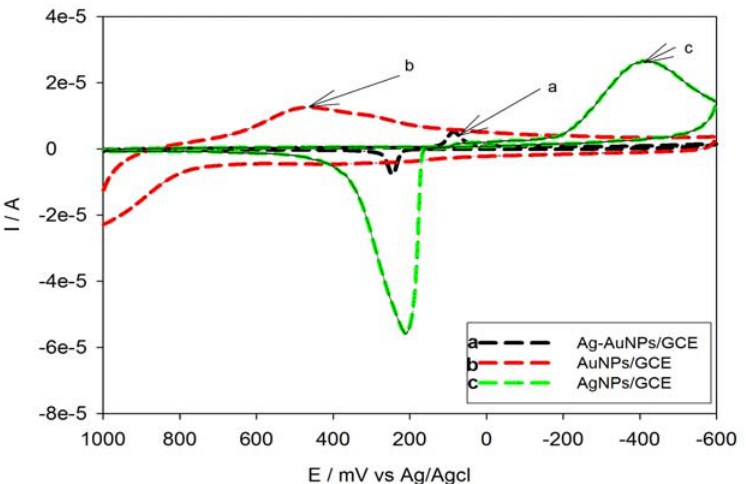
Figure 4 . Cyclic voltammograms of the overlay of Ag-AuNPs/GCE (curve a ), AuNPs/GCE (curve b ) and AgNPs/GCE (curve c ) in 0.1 M phosphate buffer pH 7; Scan rate 50 mV s − 1